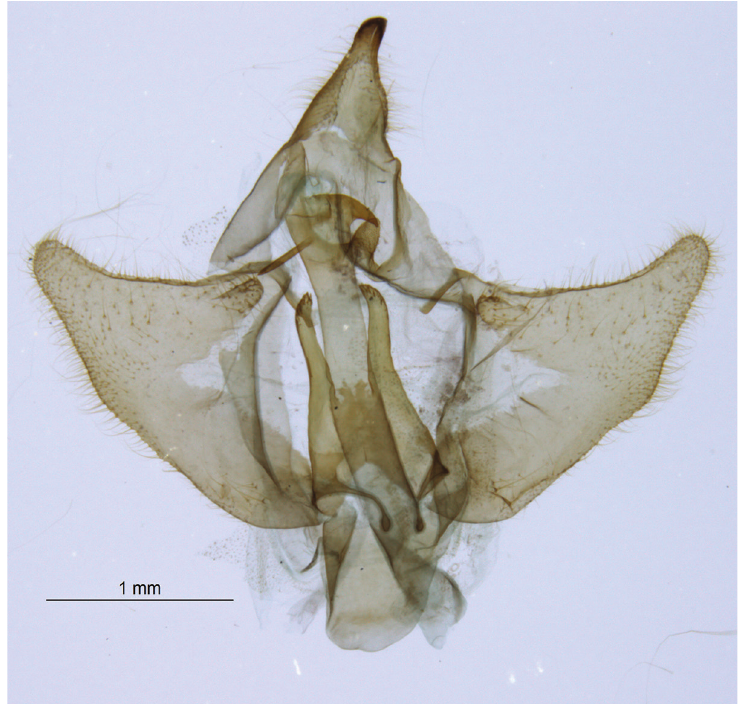
Figure 5. Vansoniella chirindensis sp. n., male genitalia slide Mey 85/17, caudal view